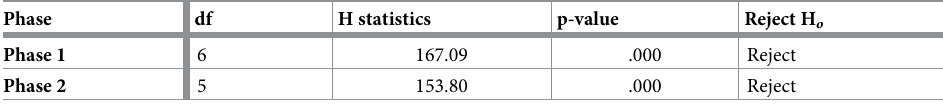
Table 20. Kruskal-Wallis test statistics for Emotion.